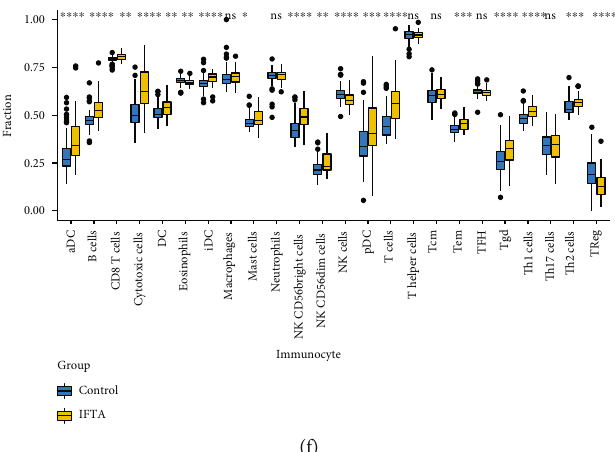
Figure 1: Work fl ow chart and immune landscape analysis of IF/TA group and control group. (a) Work fl ow chart of this study, drawn with online tool SangerBox (http://vip.sangerbox.com). (b – d) The immune and stromal scores were analyzed using the ESTIMATE algorithm (vs. control, P < 0 : 0001 ). (e) Heatmap of immune cell in fi ltration. Each small square represents each immune cell gene set and its color represents the size of the gene expression. The greater the expression, the deeper the color (red is high expression and blue is low expression). The fi rst line represents sample grouping, lake blue represents control sample, and pink represents IF/TA sample. Each row represents the expression of each gene set in di ff erent samples, and each column represents the expression of all gene sets in each sample. (f) The abundance of immune cells in ssGSEA. ∗ in the fi gure is a signi fi cance marker, ∗ stands for P < 0 : 05 , ∗∗ stands for P < 0 : 01 , ∗∗∗ stands for P < 0 : 001 , and ∗∗∗∗ stands for P < 0 : 0001